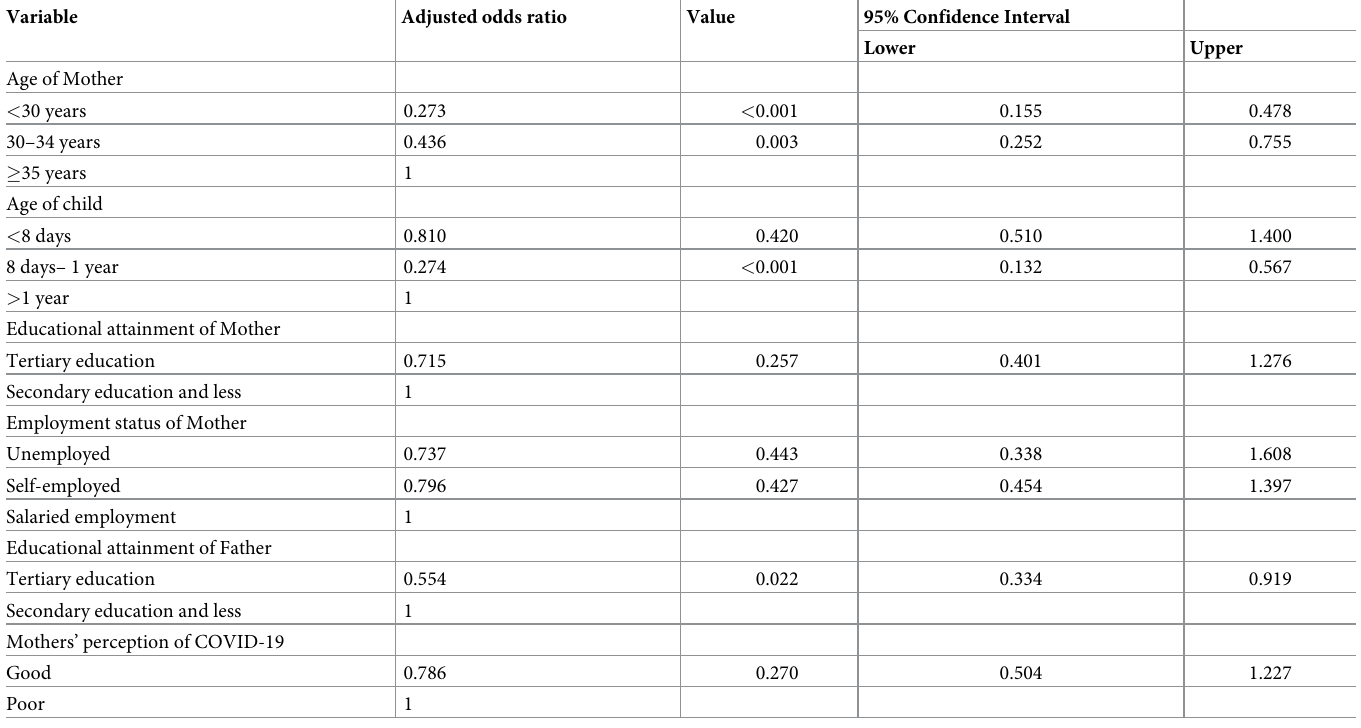
Table 3. Predictors of the use of face mask by the